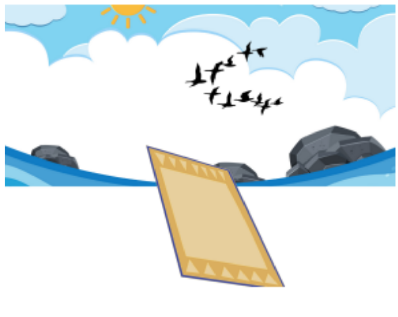
Figure 8. Interface of the game “Magic